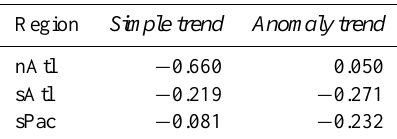
Fig. 9. Times series of the PhytoDOAS diatoms (blue solid lines) and coccolithophores (green dashed lines) – both presented as chl a conc. – in three study regions: nAtl (upper panel), sAtl (middle panel) and sPac (lower panel). Table 1. MLD trends in selected